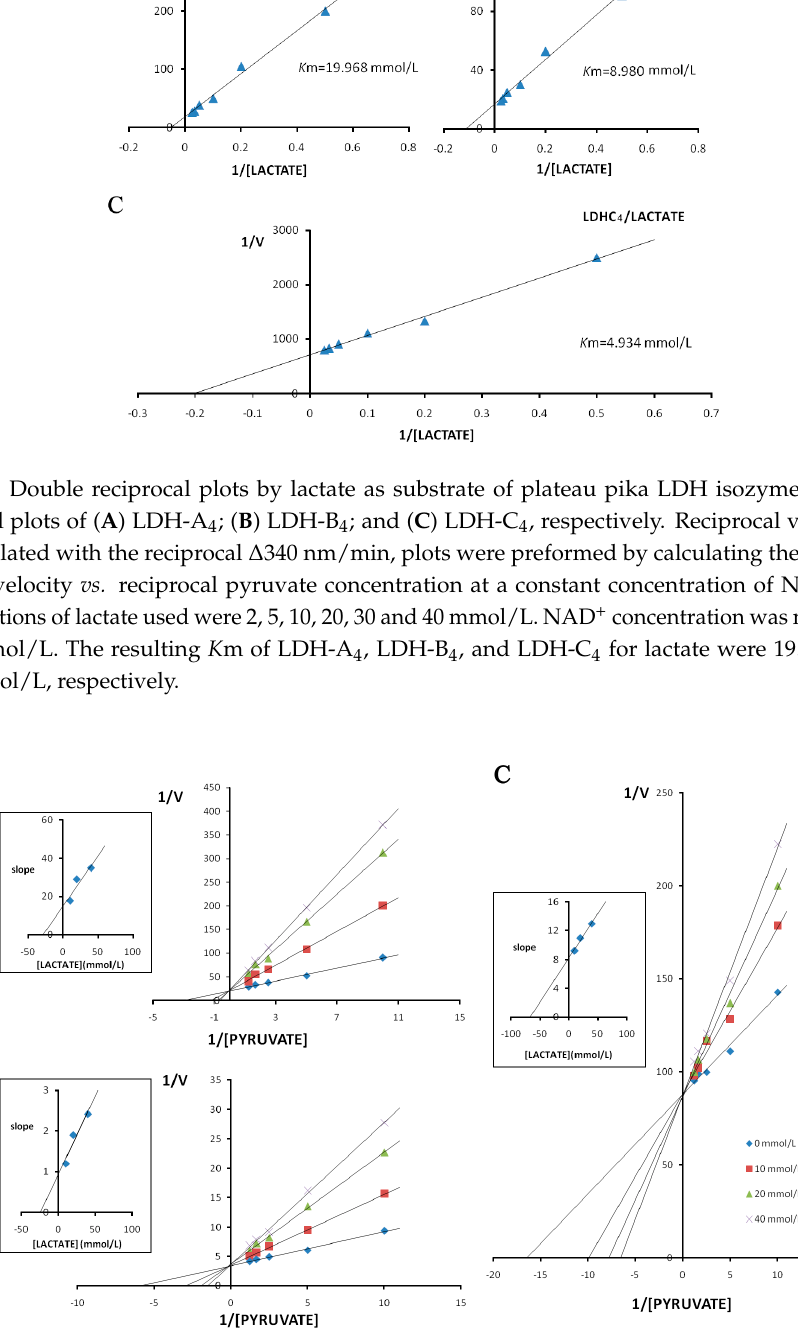
Figure 7. Effect of pyruvate on the inhibitory activity of lactate on plateau pika LDH isozymes. Double reciprocal plots of ( A ) LDH-A 4 ; ( B ) LDH-B 4 ; and ( C ) LDH-C 4 , respectively. Reciprocal velocity ( V ) was calculated with the reciprocal ∆ 340 nm/min, plots were preformed by calculating the reciprocal value of reaction velocity vs. reciprocal value of pyruvate concentration at a constant concentration of NADH. The concentrations of pyruvate used were 0.1 0.2, 0.4, 0.6 and 0.8 mmol/L. NADH concentration was maintained at 0.15 mmol/L. Upper left: determination of K i from plots of slope values against lactate concentrations. The resulting K i for pika LDH-A 4 , LDH-B 4 , LDH-C 4 by lactate were 25.9, 22.2 and 66.5 mmol/L,